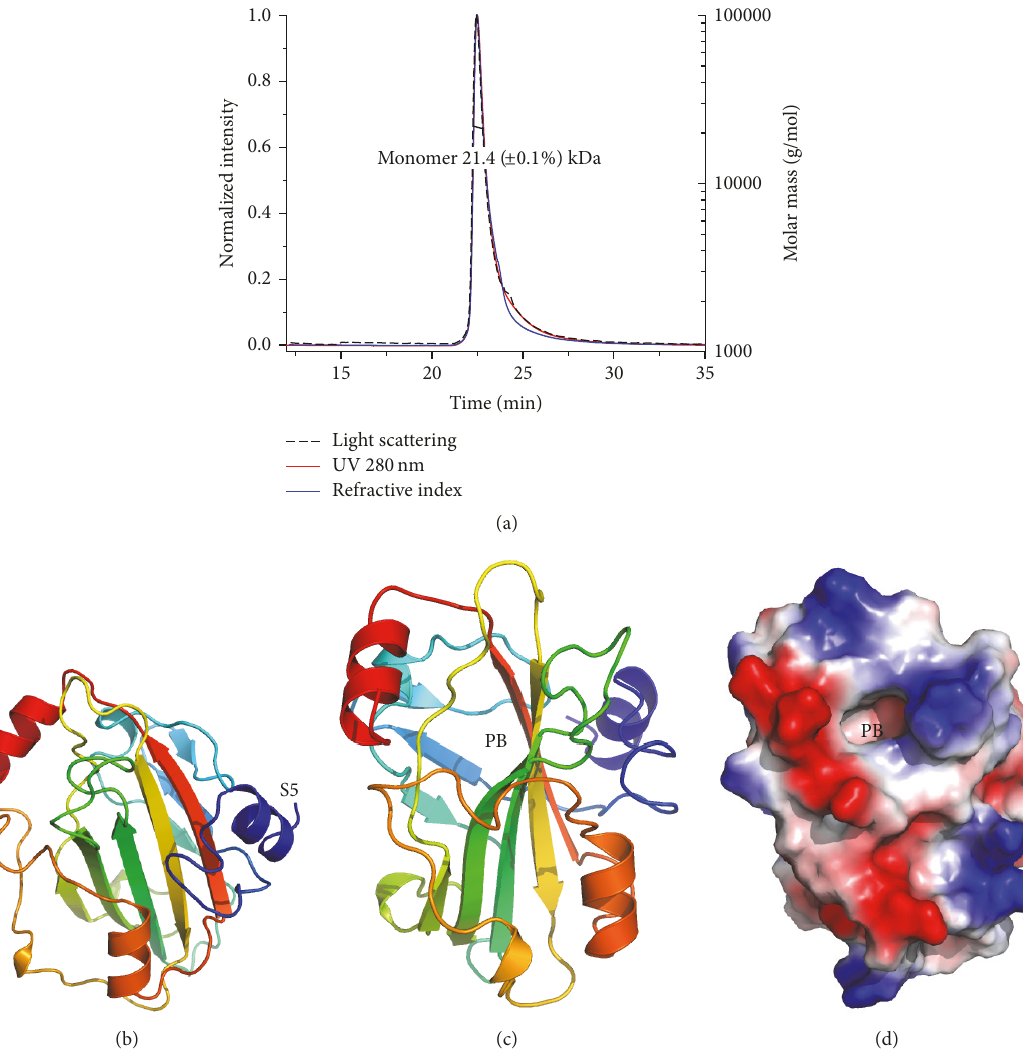
Figure 4: (a) Tm16 is an ∼ 21kDa monomer in solution according to size-exclusion chromatography and multiangle light scattering analysis. (b) Ribbon diagram of Tm16 monomer colored in rainbow from blue (N-ter) to red (C-ter). The central putative binding cavity (PB) is visible in ribbon diagram (c) and electrostatic surface plot